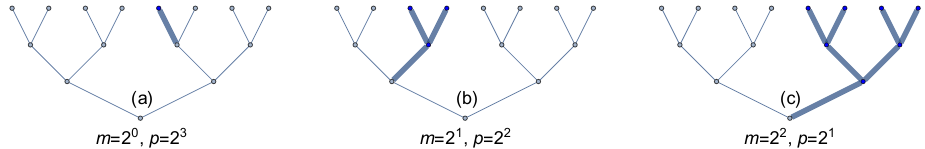
Figure 1. Number of mutants in a growing population depends on the time of the first mutation. ( a ) When the first mutation happens in the last cell division, then only one cell mutation. In this case, there are p = 2 3 different final cells that could be mutated in the final round of cell division, so such mutations confined to a single cell will be relatively common. ( b ) When the first mutation happens in the second to last cell division, then two cells this case, there are p = 2 2 different final groups of cells that could be mutated, so such mutations confined to two cells will be 1/2 as common as for singleton mutations. ( c ) When the first mutation happens in the third to last cell division, then four cells there are p = 2 1 different final groups of cells that could be mutated, so such mutations confined to four cells will be 1/4 as common as for singleton mutations. Focusing on single mutational events, every doubling for the final number of mutant cells decreases the probability of occurrence by 1/2. This discrete-time model matches Haldane’s formulation of the Luria–Delbrück problem [8], used here for illustration because of its simplicity. Most modern analyses use a continuous time formulation [7]. In the text, the mixture of references to the discrete and continuous formulations leads to a mixture of comments about mutation probabilities and mutation rates. When the underlying formulation is ambiguous, I use mutation